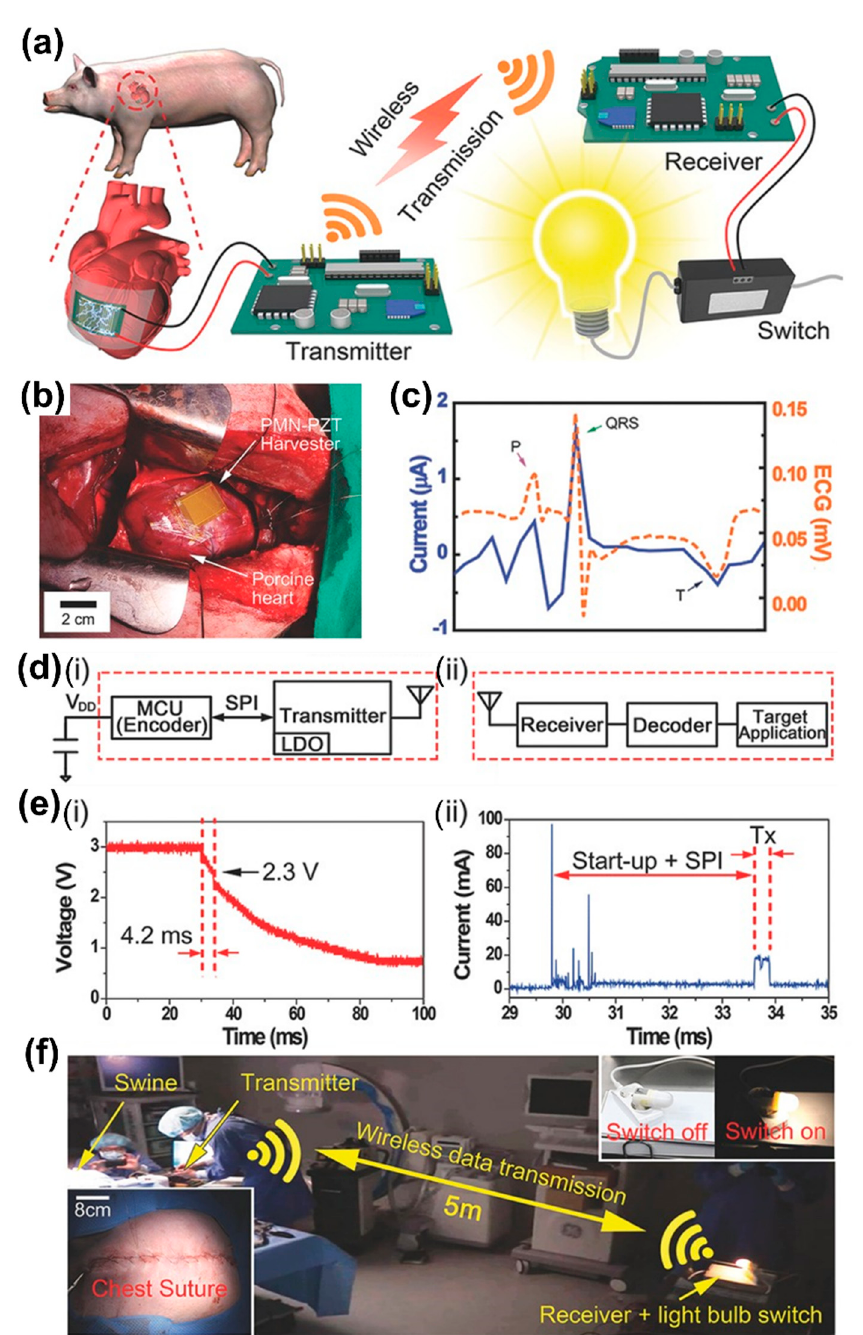
Figure 12. ( a ) Experimental schematic representation of in vivo self − powered wireless data trans- mission using flexible a PMN − PZT-Mn energy harvester attached to a porcine heart. ( b ) Photograph of flexible PMN − PZT − Mn harvester attached to a porcine heart. ( c ) Magnified current and ECG response from the porcine heartbeat. ( d ) Circuit diagrams of the wireless communication module consisting of ( i ) transmitter and ( ii ) receiver parts. ( e ) Specifications of the wireless communication module. ( f ) Photograph of big animal experiment. Reproduced with permission [133].